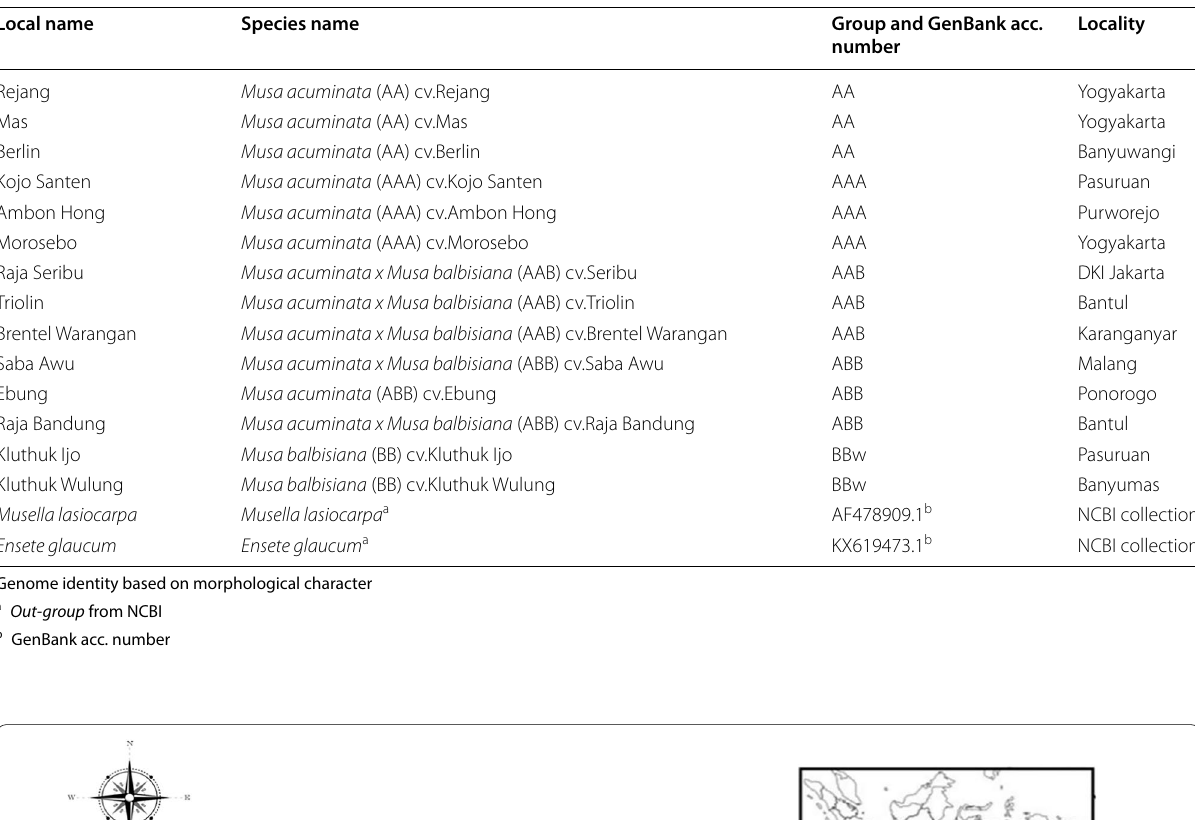
Table 1 Diagnostic list of 14 banana cultivars from Java Island and outgroup used in this study